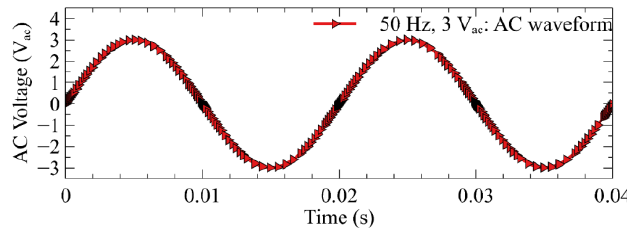
Figure 5. Applied ideal sinusoidal AC voltage.